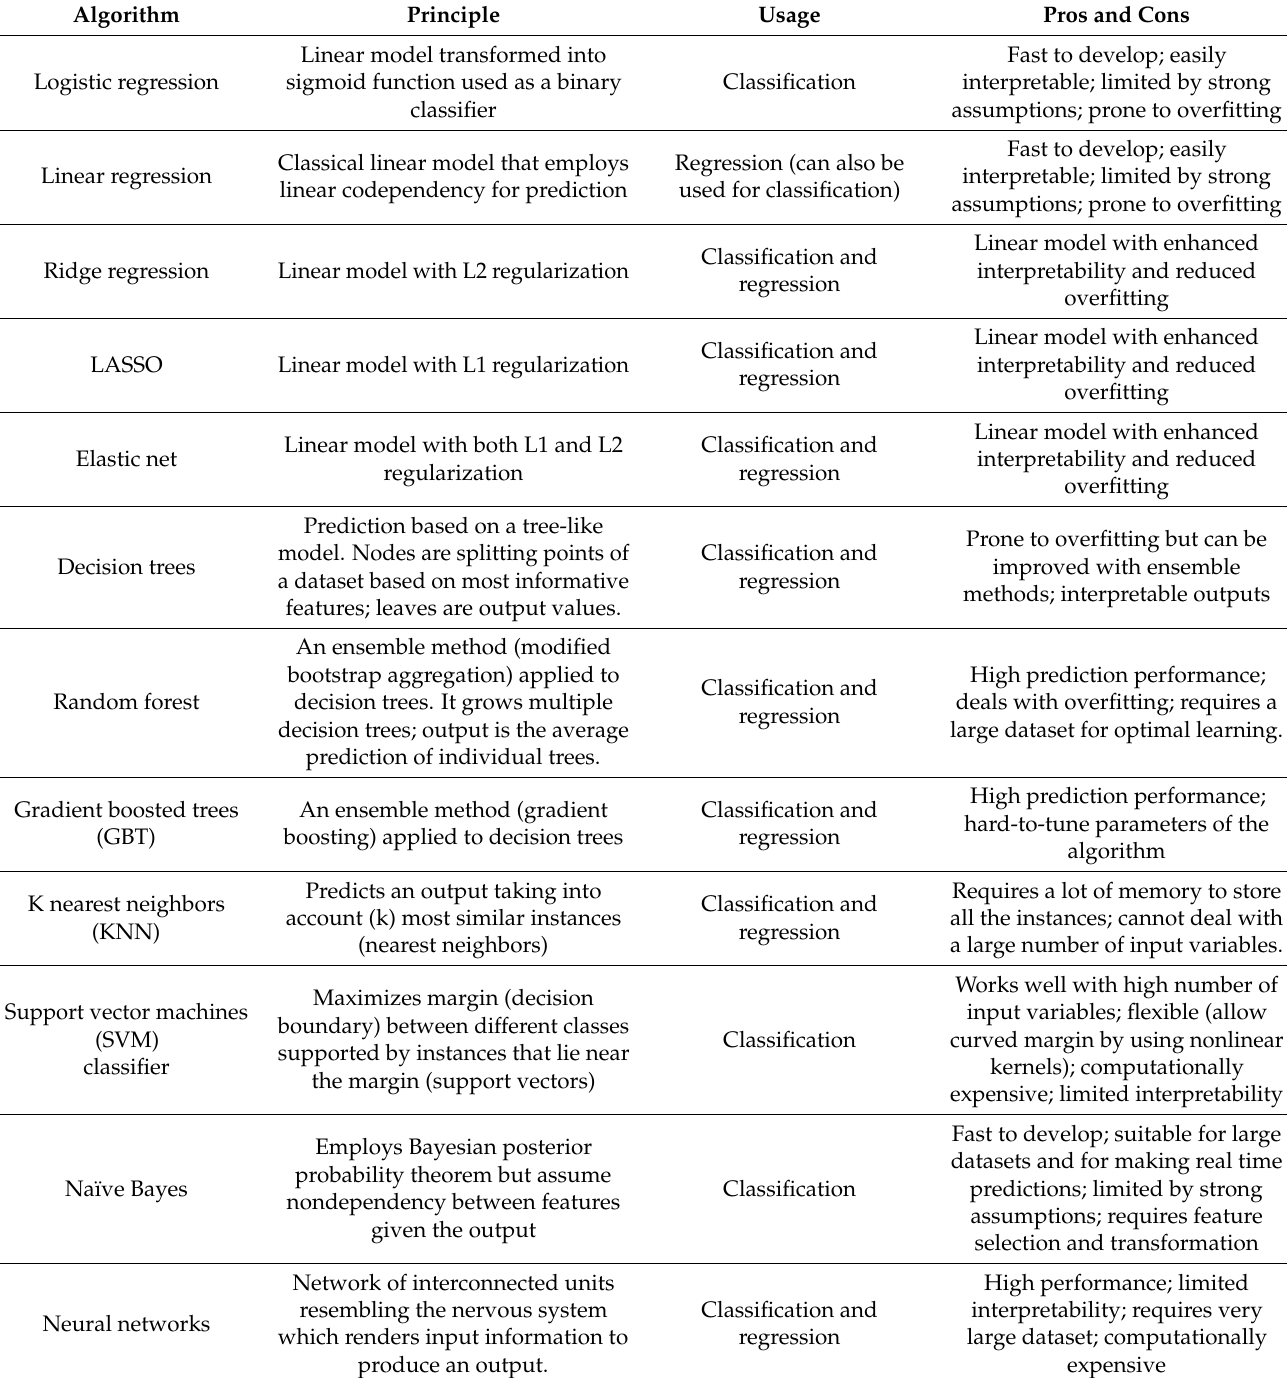
Table 2. Classification and regression machine learning algorithms employed in IBD